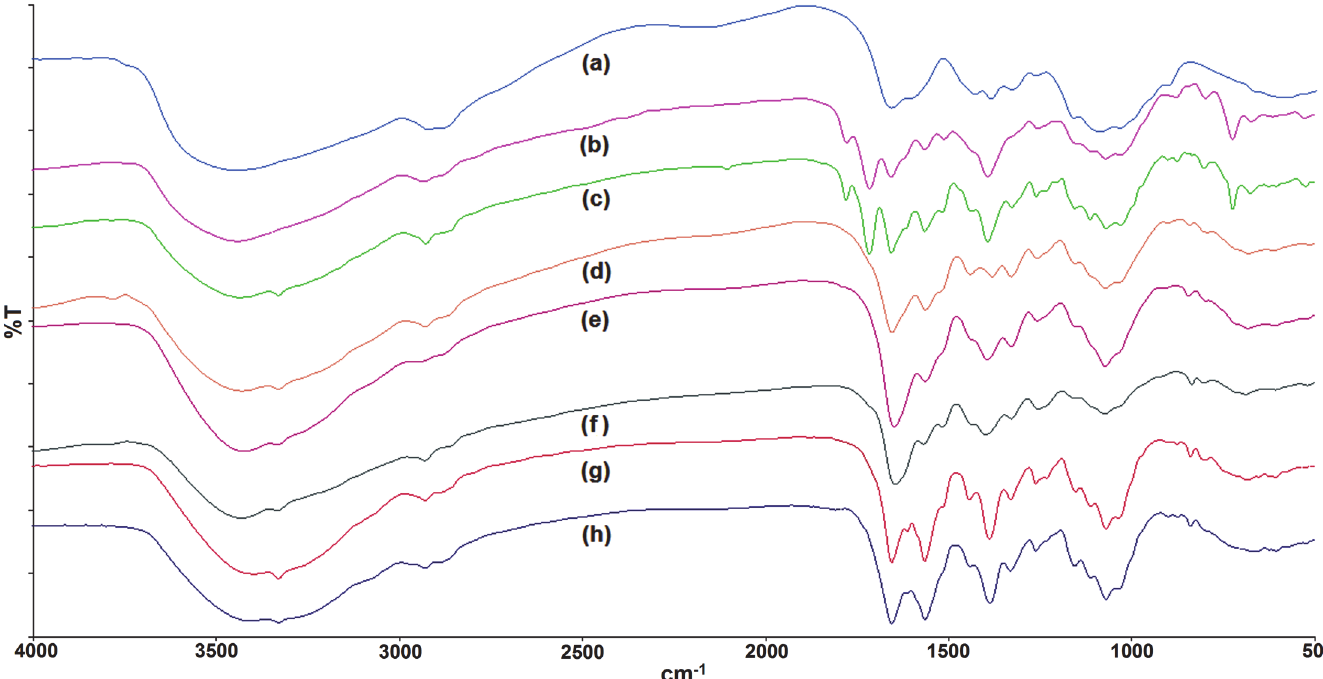
Fig 2. Fourier transform infrared (FTIR) spectra. Figure showing fouriertransforminfrared (FTIR) spectra of (a) Chitosan, (b) N -phthaloyl-chitosan, (c) N - phthaloyl-chitosan O-prop-2-ynyl carbamate, (d) derivative 1, (e) derivative 2, (f) derivative 3, (g) derivative 4, and (h) derivative 5.